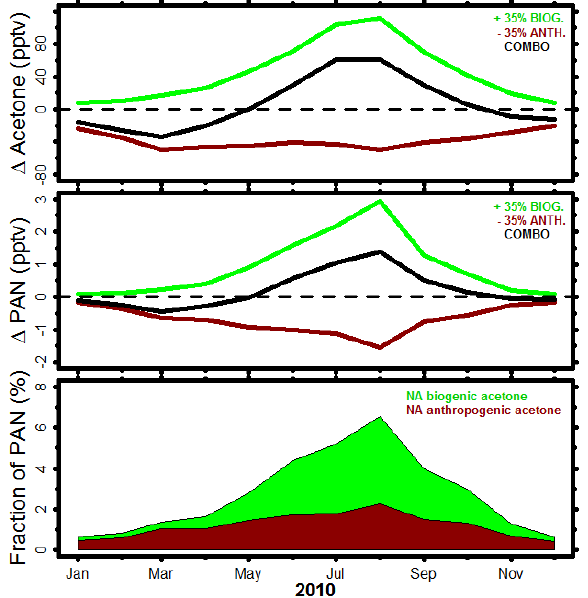
Fig. 8. Simulated change (pptv) in seasonal acetone (top panel) and PAN (middle panel) mixing ratios at 700hPa for the sensitivity runs shown in Fig. 7. The bottom panel shows the fractional contribution of biogenic and anthropogenic acetone sources in North America to the simulated PAN abundance. Values shown represent an average over continental North America.